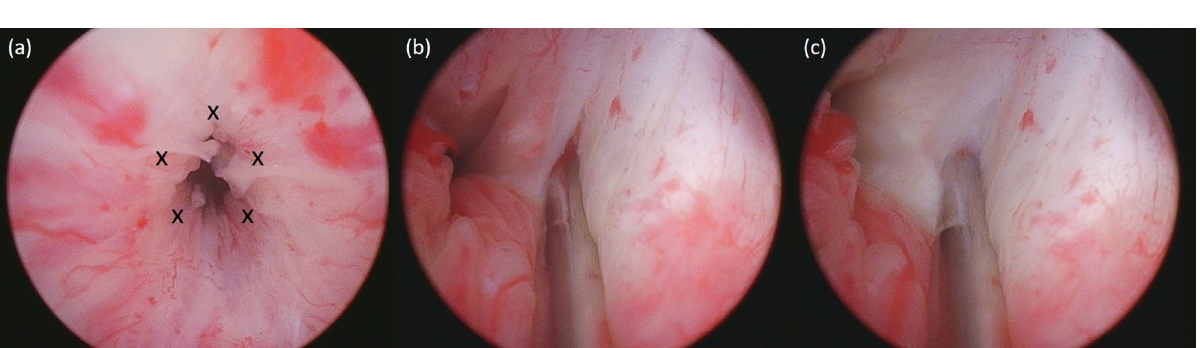
Figure 2. Transurethral urethral sphincter injection of platelet-rich plasma in patients with post-prostatectomy incontinence ( a ) Crosses indicate injection sites; ( b ) The needle was injected at a depth of 0.5 cm; ( c ) Swelling of the urethral surface after the